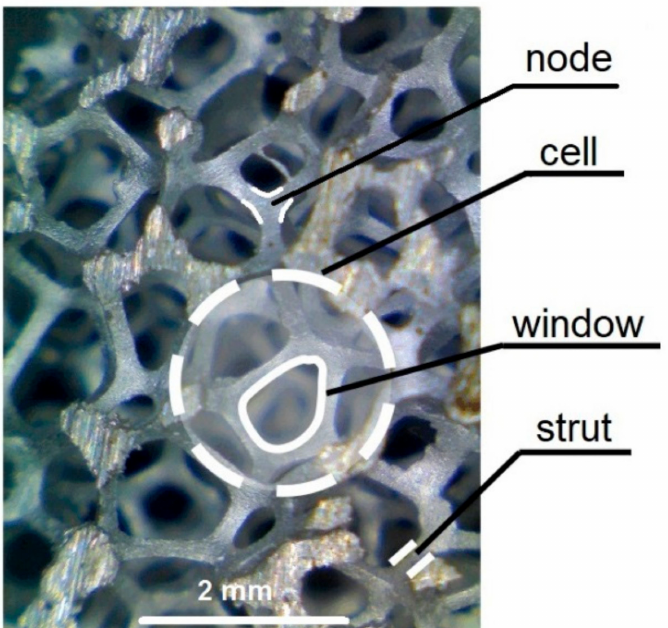
Figure 3. Foam matrix.